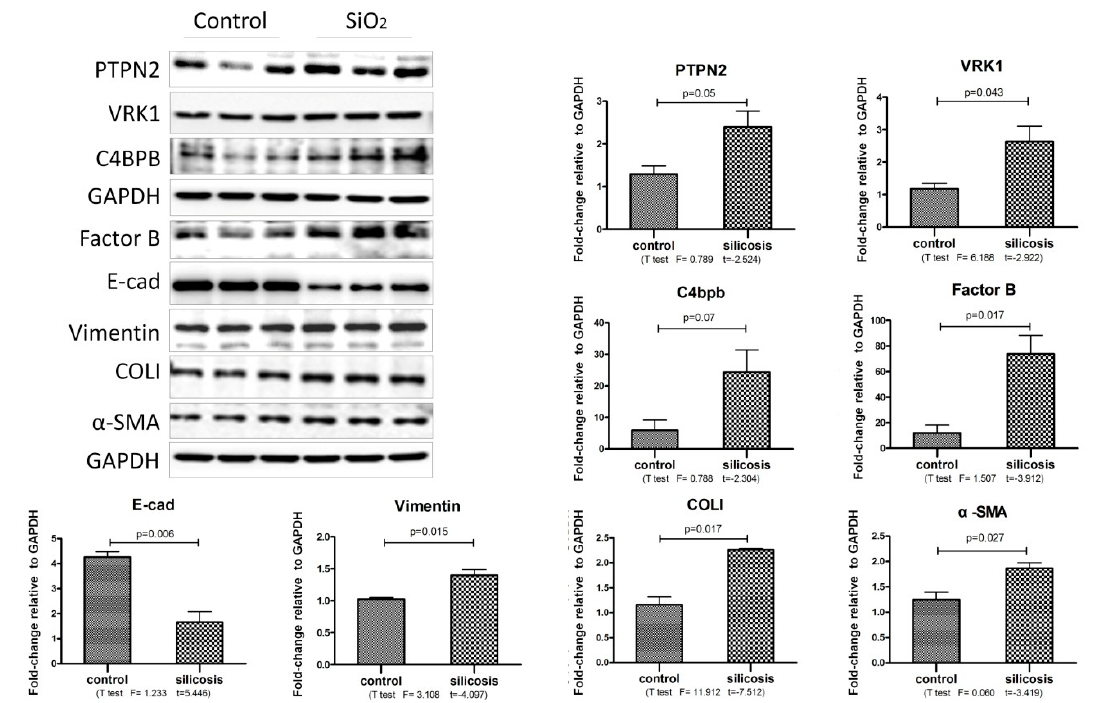
Figure 4. The increased proteins expression in SiO 2 stimulated MLE-12 cells. Western blot and corresponding densitometry data of the expression levels of PTPN2, factor B, VRK1, C4BPB, E-cad, Vimentin, Col I and α -SMA in MLE-12 cells on SiO 2 (50 µ g / mL) stimulated 24 h. Statistical analysis was performed using a t-test with SPSS20.